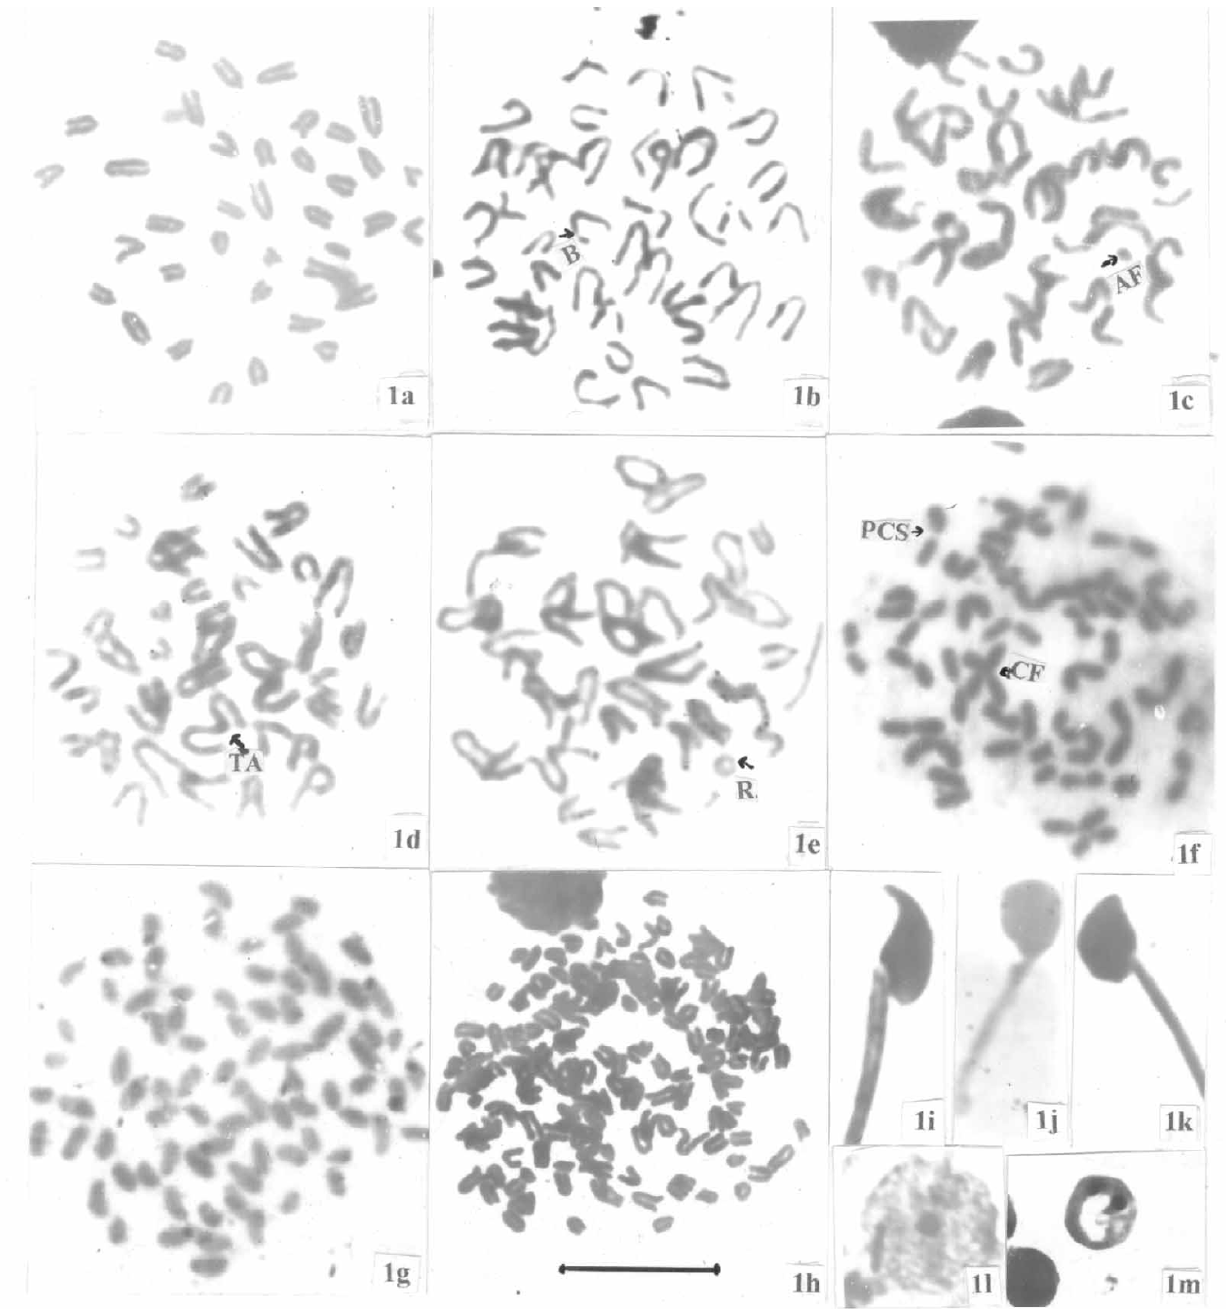
Figure 1 a-m: Photomicrographs of metaphase complements showing normal set of chromosomes (la), and chromosome aberrations like break (B, 1b), acentric fragment (AF, 1c), terminal association (TA, 1d), ring (R, 1e), centric fusion and precocious centro- meric separation (If), C mitosis (1g) polyploidy (1h); sperm with normal (1i), and abnormal (1j-1k) head morphology; normo- (1l), and poly- (1m) chromatic erythrocytes. Bar represents 10 µ